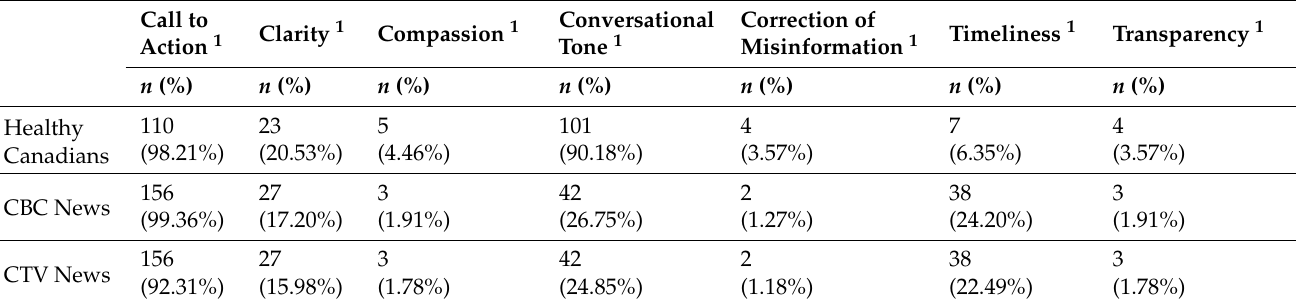
Table 3. Number and percentage of Facebook posts incorporating seven guiding principles for social media crisis communi- cation used by Healthy Canadians, CBC News, and CTV News.